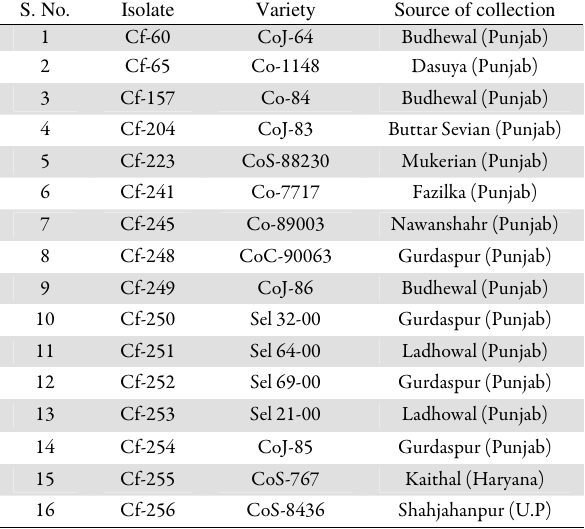
Tab. 1. Isolates of Colletotrichum falcatum used in this study and their place of